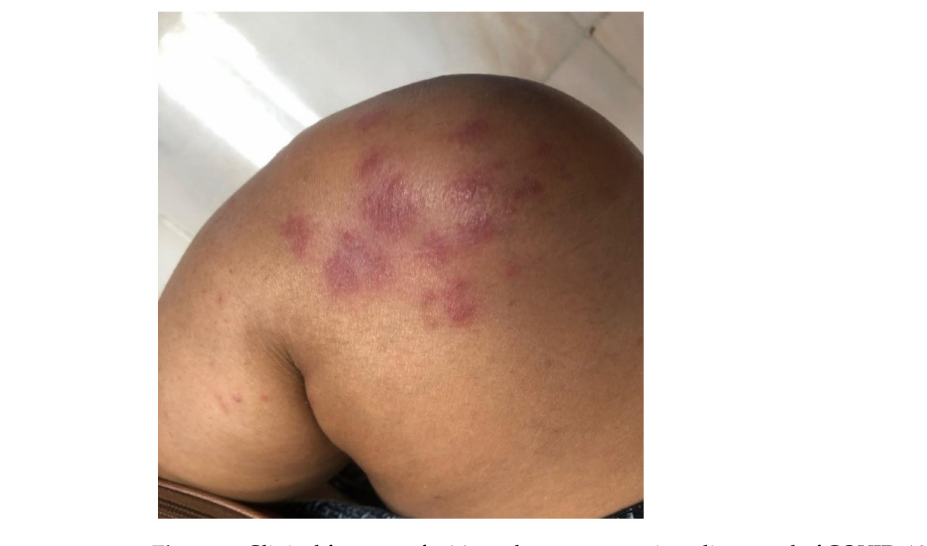
Figure 1. Clinical features of a 16-week pregnant patient diagnosed of COVID-19 with dusky purpuric patches on the knee.